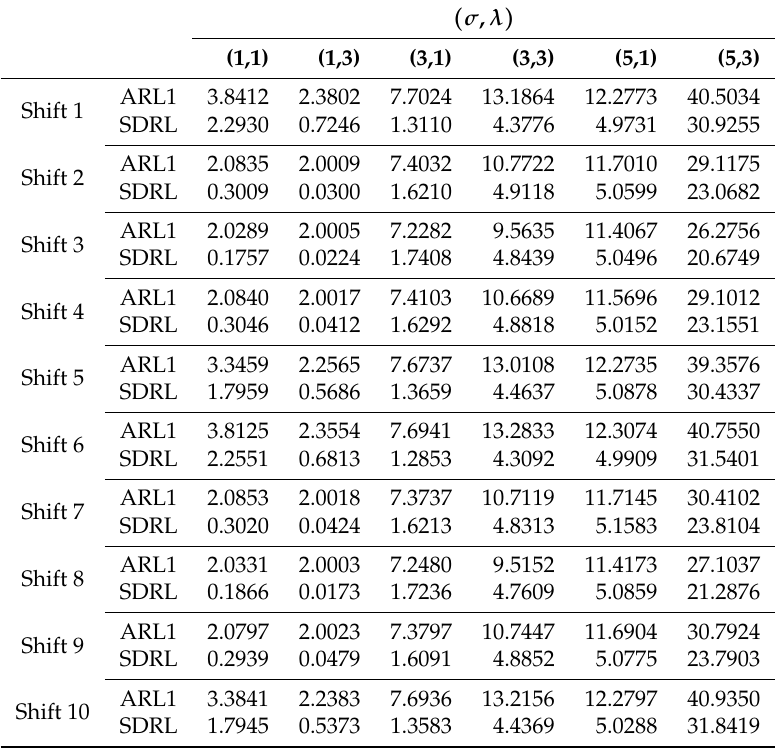
Table 1. The ARL 1 and SDRL of the MS-MAE chart for different combinations of σ , λ and ξ =